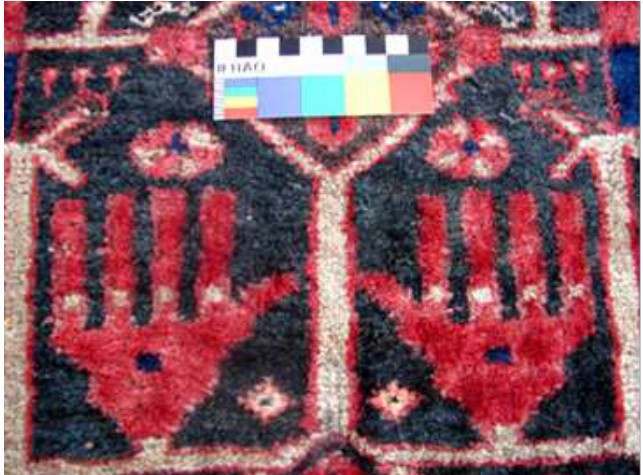
Figure 18. The hand form on a handmade carpet related to 100 years ago, woven in Saral in